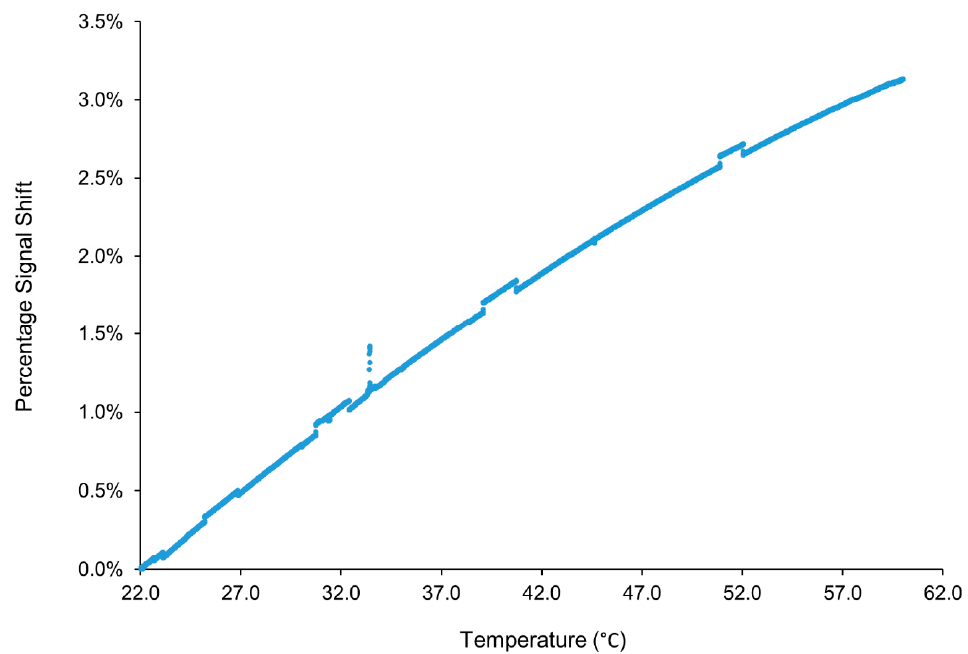
Figure A4. Sensor thermal sensitivity. Sensor oscillation frequency, and thus proximity counts, were linearly proportional to the temperature of the sensing environment.